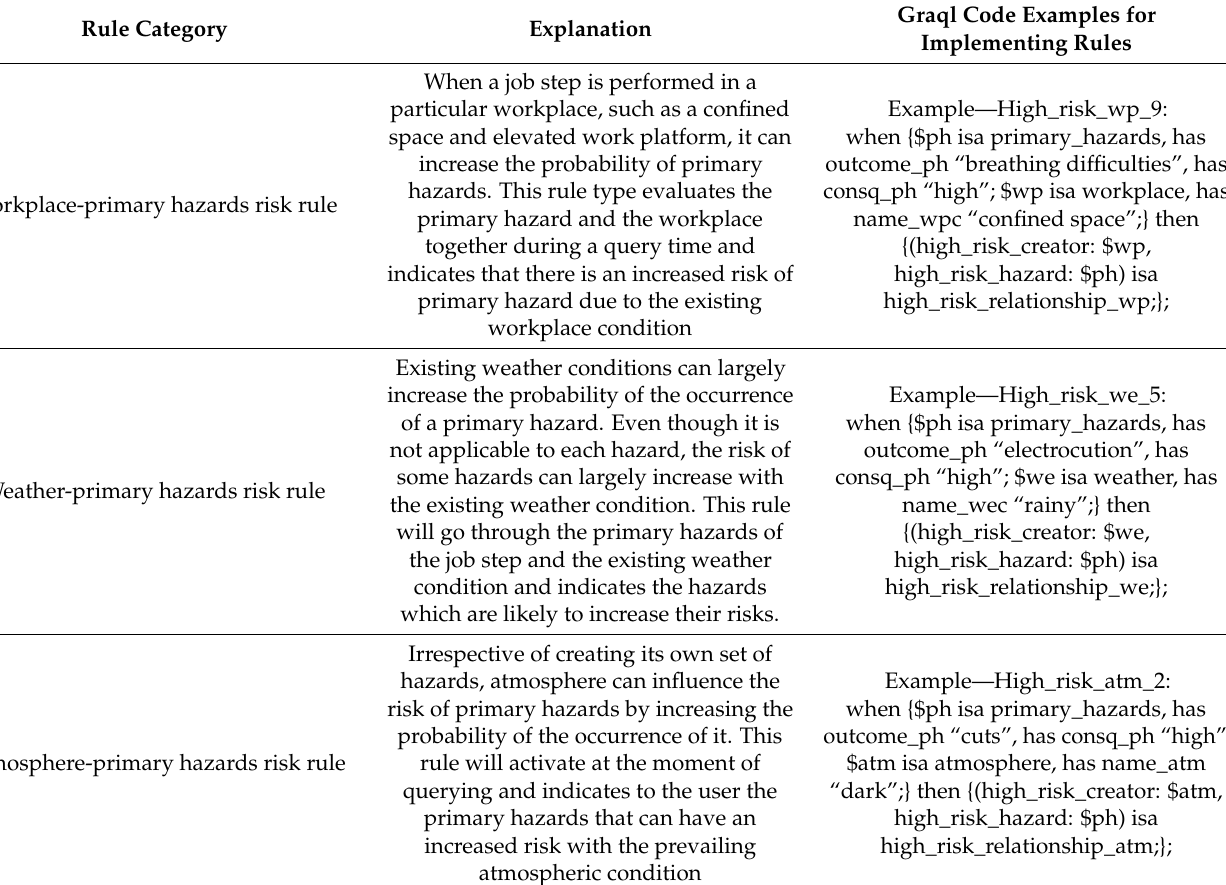
Table 4. Example of rules for risk